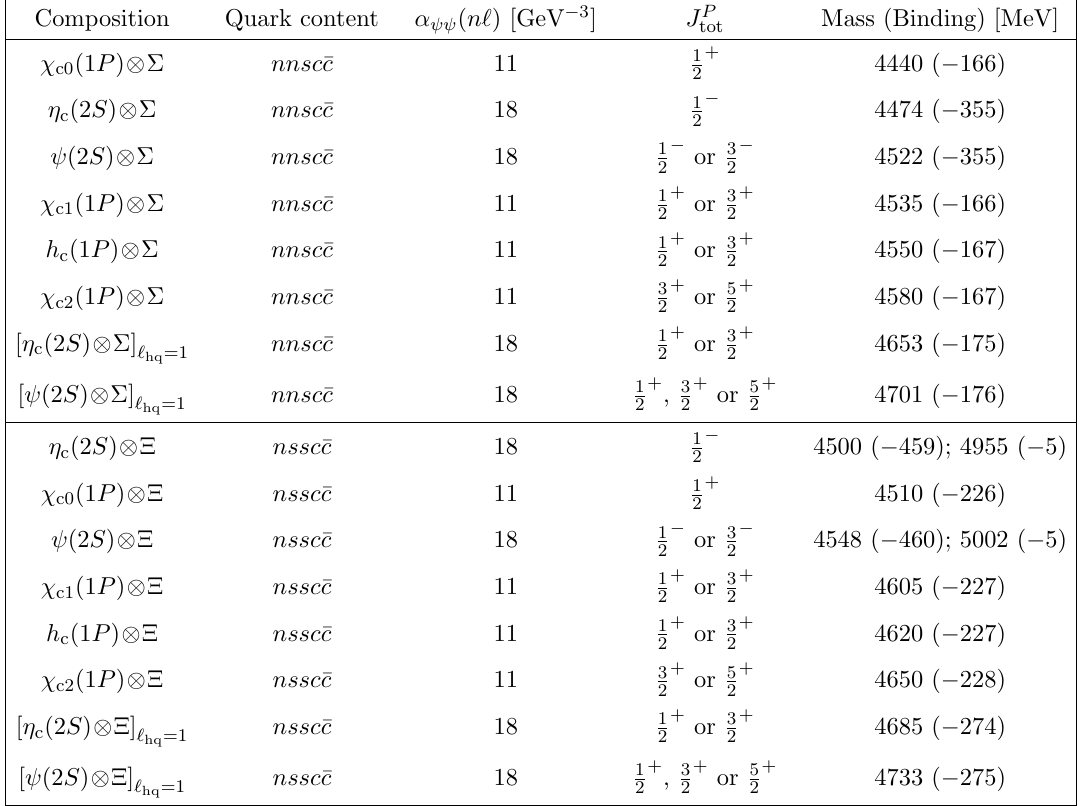
Table 2 . Hadro-quarkonium model predictions for charmonium-(cid:6) and (cid:4) bound states. The pen- taquark binding energies and masses (5th column) are calculated with the values of the chromo- electric polarizabilities (cid:11) ( n‘ ) (3rd column). Here, n = u or d . The bound states are S